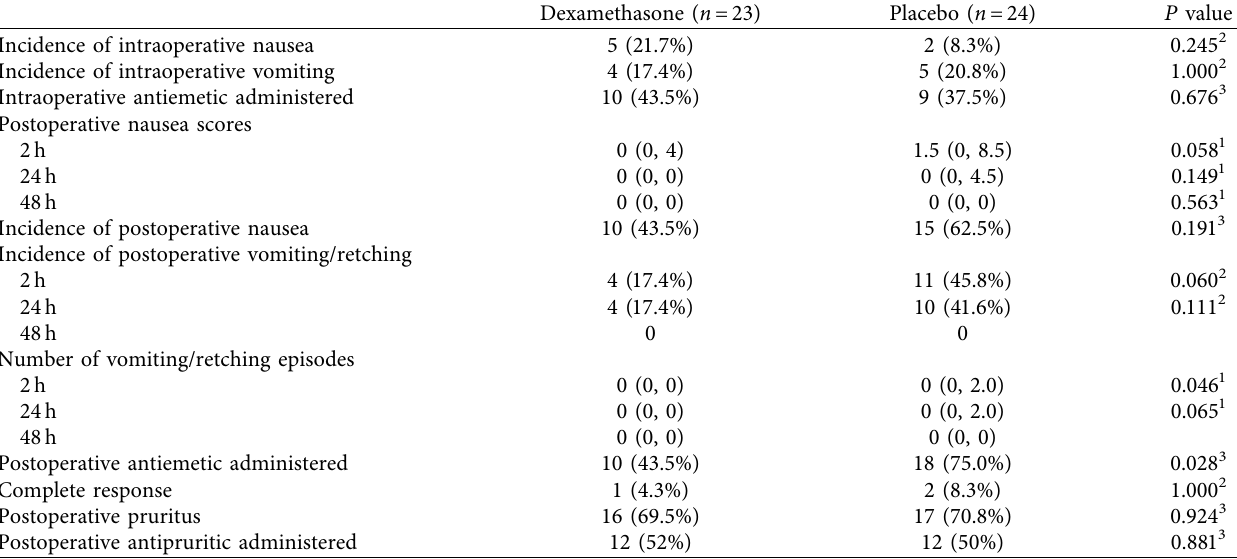
Table 3: Intraoperative and postoperative nausea and vomiting and pruritus